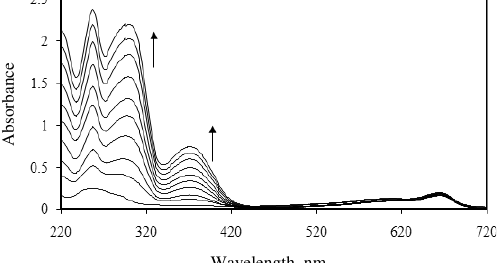
Figure 7. Absorption spectra of the competitive interaction between MTX and methylene blue bonded to DNA at C =0.0, 10.0, 20.0, 30.0, 40.0, 50.0, 60.0, 70.0, 80.0 and MTX 90.0 µ mol L -1 for curves 1-10, C =20.0 µ mol dm -3 and c =27.6 µ mol L -1 in phosphate MB DNA buffer (0.1 mol L -1 , pH 7.4) plus NaCl (0.1 mol L -1 ) Melting studies